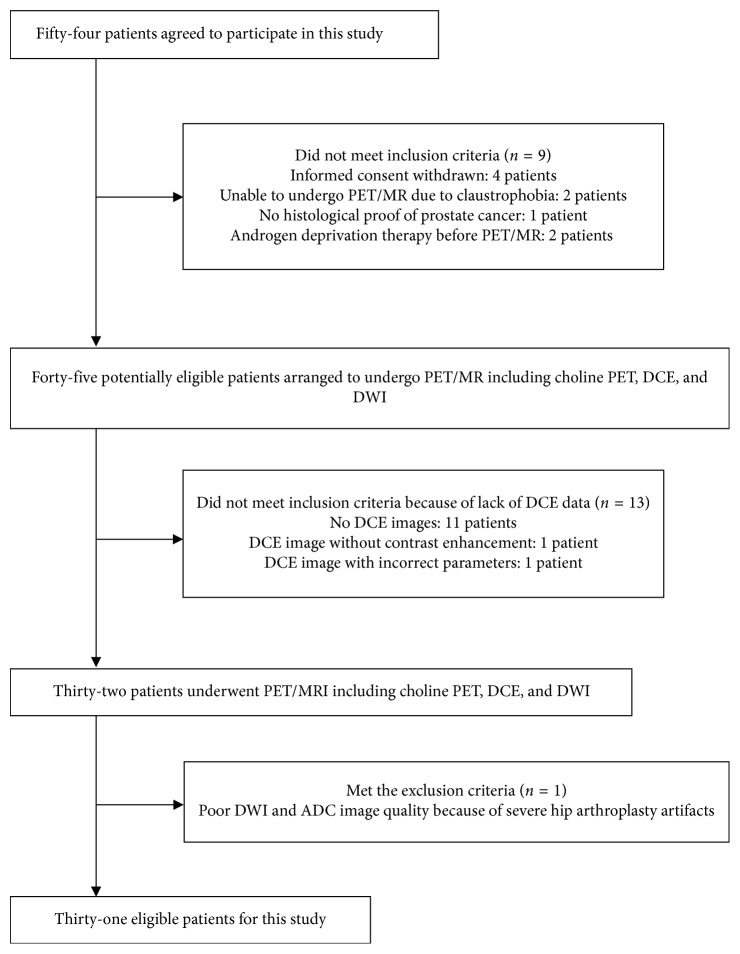
Flow diagram of the 31 patients eligible for this study.